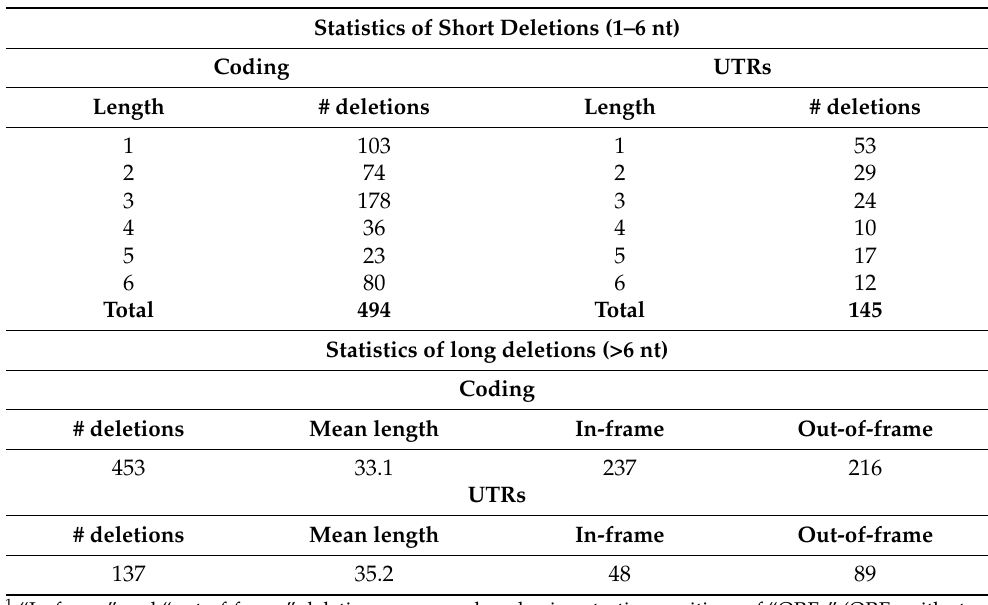
Table 1. Statistics of short and long deletions 1